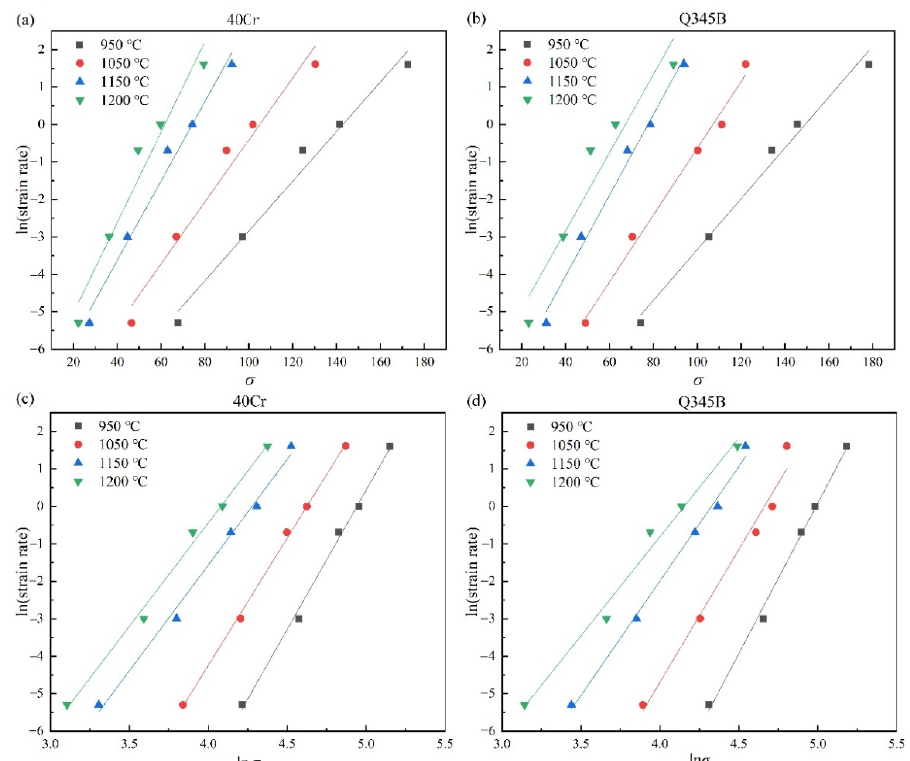
. . ε − σ ( a , b ) and ln ε − ln σ ( c , d ) for 40Cr and Q345B, respectively. Figure 10. Relationships between ln 𝜀(cid:4662) − σ ( a , b ) and ln 𝜀(cid:4662) − ln σ ( c , d ) for 40Cr and Q345B, respectively.